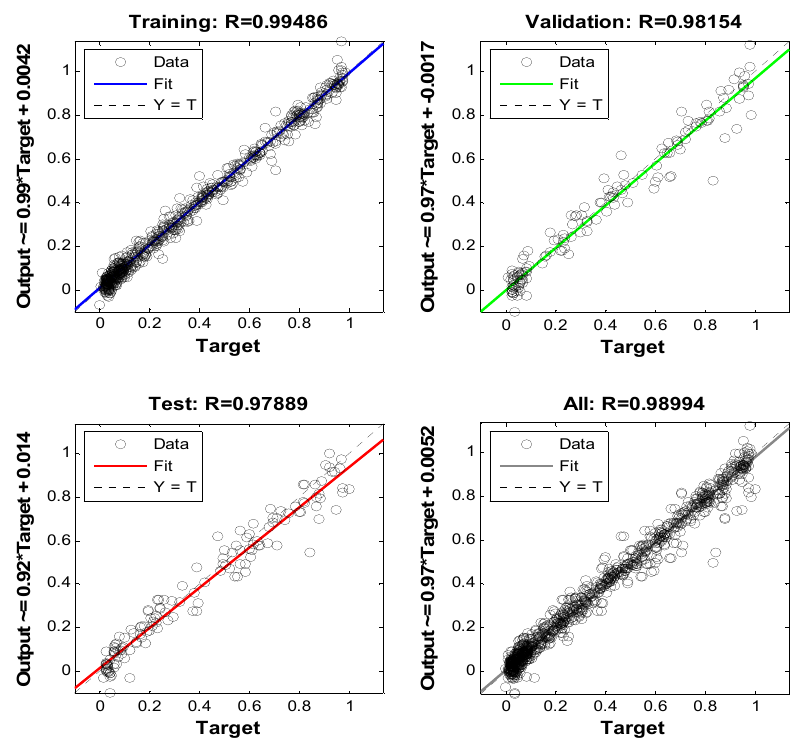
Figure 12. Regression of the BP neural network.